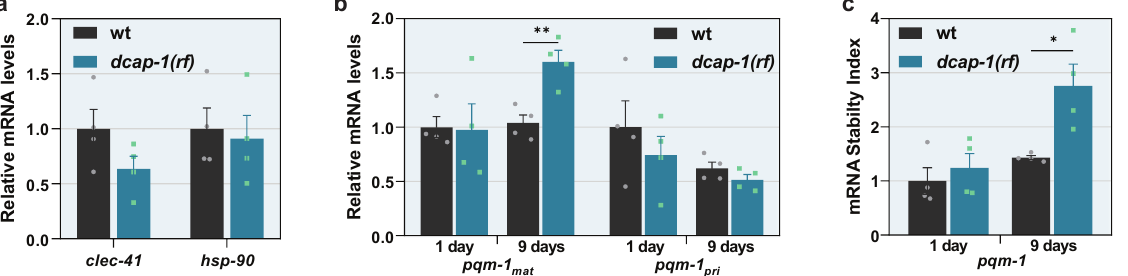
Figure 5. PQM-1 activation is traced to the stabilization of pqm-1 transcripts in ageing dcap-1(rf) animals. ( a ) Relative mRNA levels of clec-41 and hsp-90 in wt and dcap-1(rf) 9 day-old worms. ( b , c ) Relative levels of mature (mRNA mat ) and primary (mRNA pri ) pqm-1 transcripts ( b ) and stability of mature pqm-1 transcripts ( c ) in wt and dcap-1(rf) worms at the 1st and the 9th day of adulthood. Symbols represent individual values. Bars represent mean ± SEM. * p < 0.05, ** p < 0.01. Unpaired t